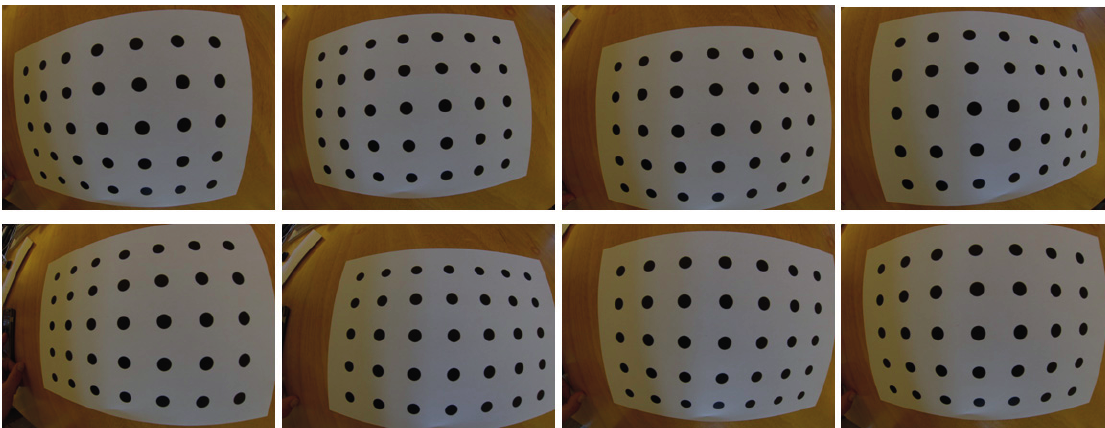
Figure 8. Images captured to perform the